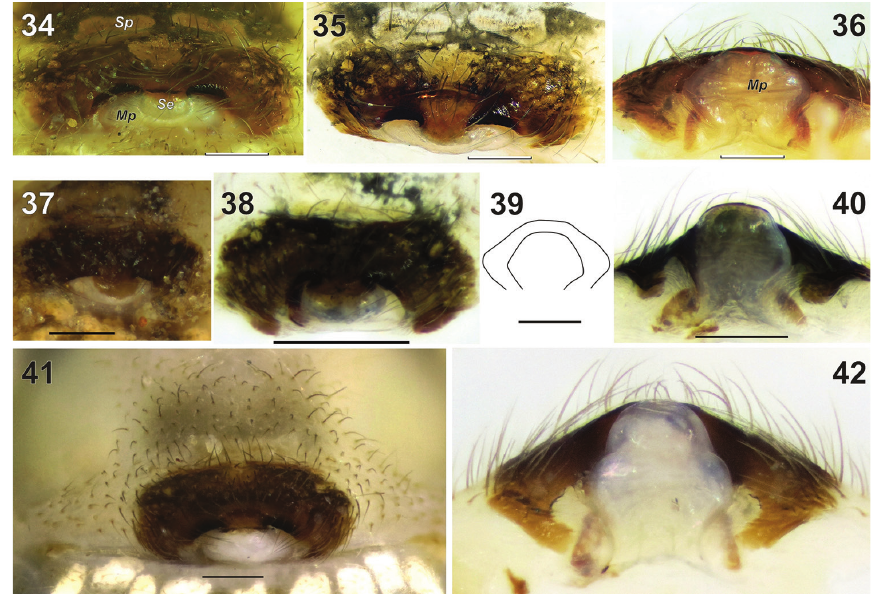
jan. Abbreviations: Sp sclerotized plate Se sclerotised outgrowth Mp median plate. Scale bars 0.2 mm